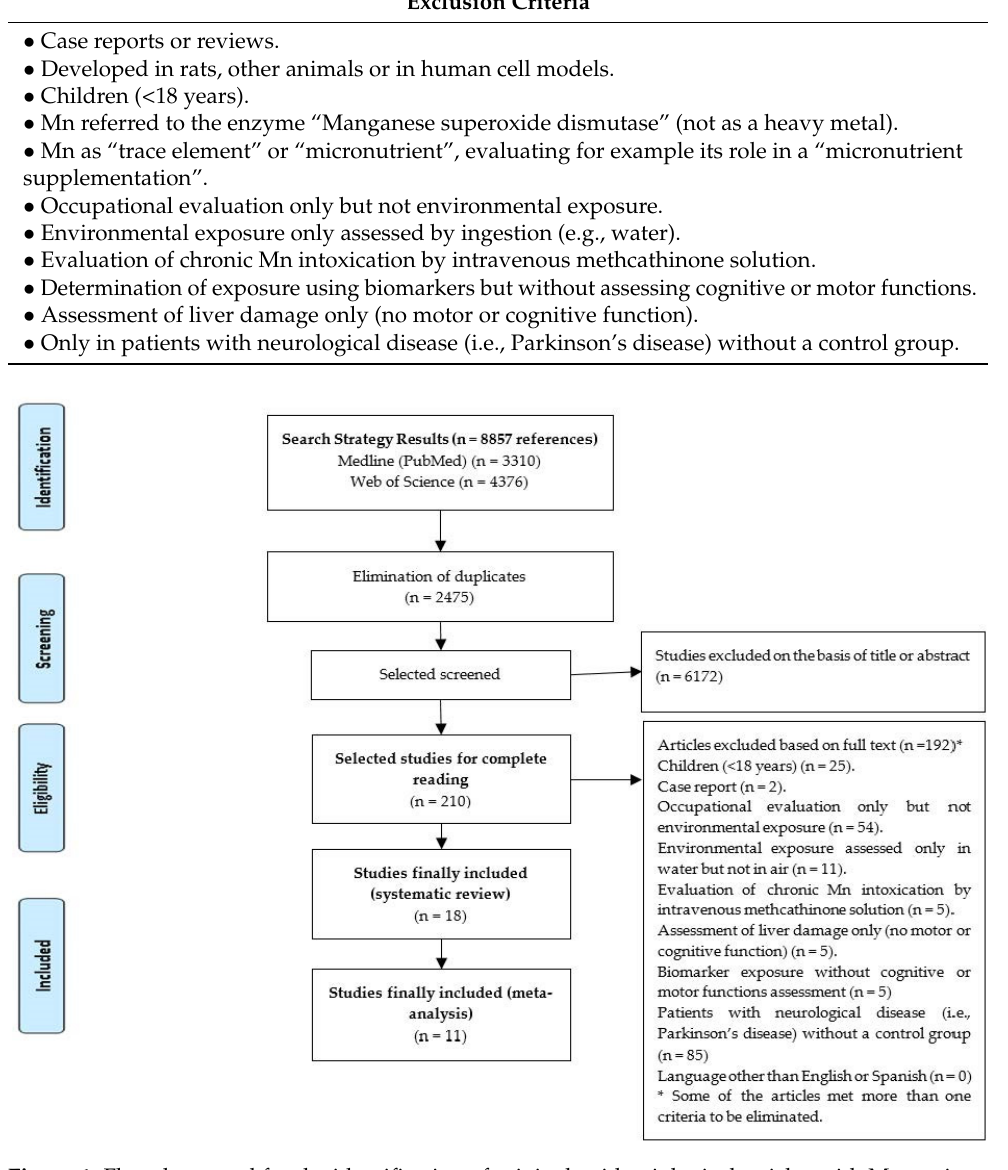
Figure 1. Flowchart used for the identification of original epidemiological articles with Mn environmental exposure determined in air and/or biomarkers in adults ( ≥ 18 years), evaluating motor or cognitive function as outcome variables.